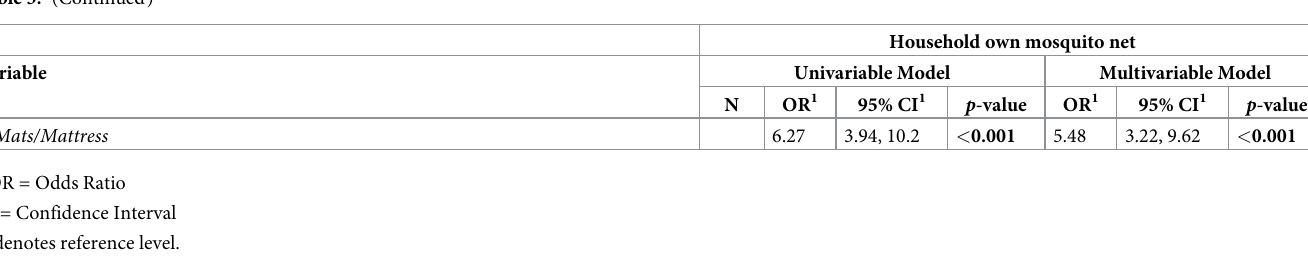
Table 6 below shows that 134 (89.3%) of the respondents stated they washed the LLINs. Most of the net washing was done monthly (66.4%). Univariable and multivariable analysis for factors independently associated with LLIN utilization and non-utilization. The results of the multivariable analysis for factors indepen- dently associated with LLIN utilization are shown in Table 7. The multivariable adjusted analyses were limited to households owning at least one LLIN.